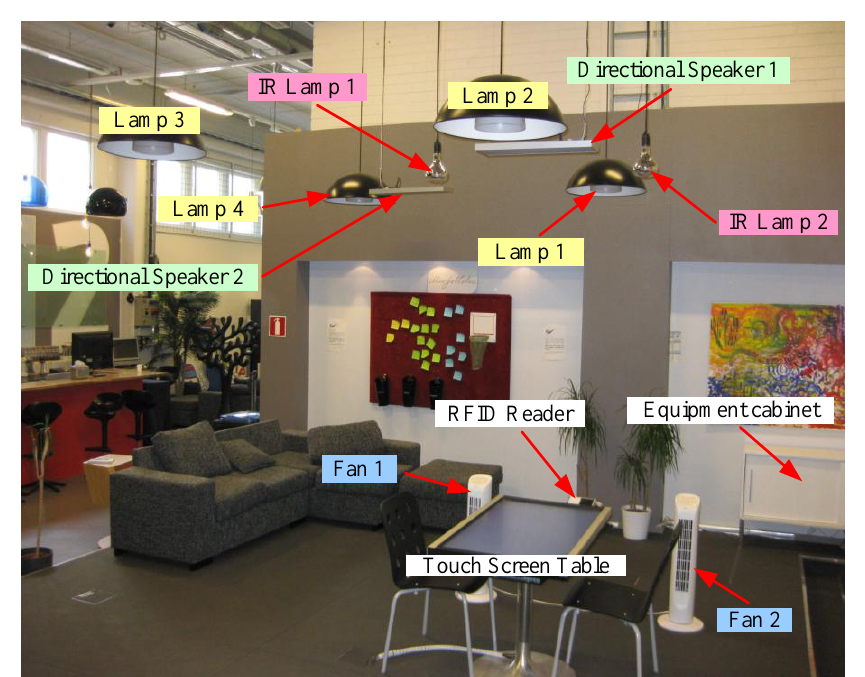
Figure 8. 4D-Space smart environment with individual environmental conditions (figure adapted with permission from Aleksi Sormanen) [25].